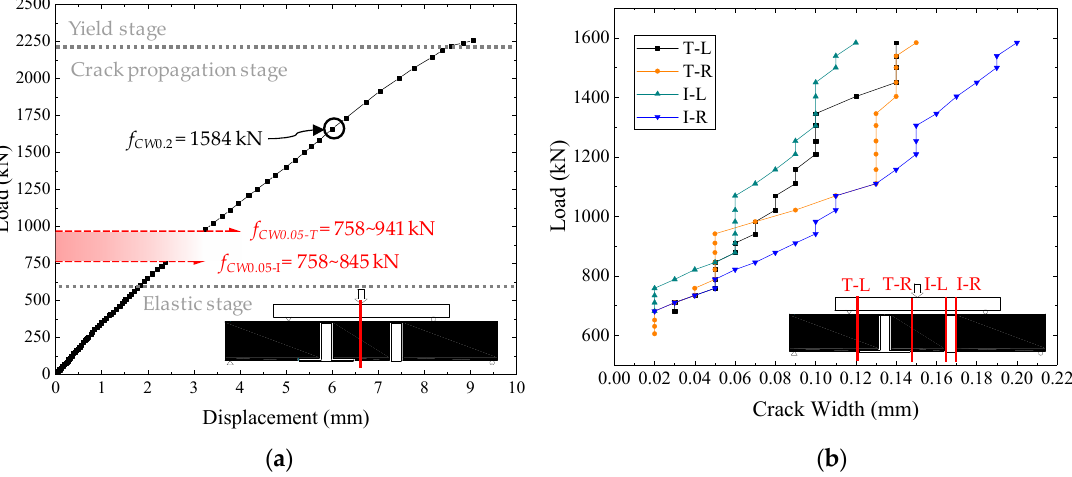
Figure 6. Test results of comparative model test: ( a ) load-deflection curve in mid-span; ( b ) load-crack width curve of joint interface. T: T-shaped joint, I; I-shaped joint, L: left side, R: right side.